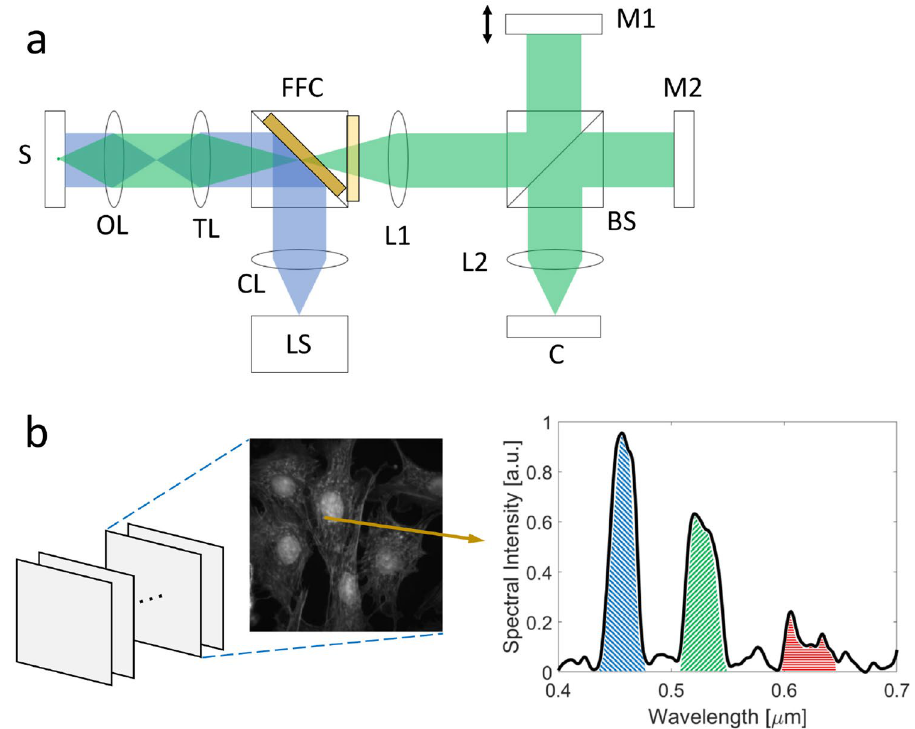
Figure 1. ( a ) Schematic diagram of the optical system showing the excitation beam path (blue) and emission beam path (green). LS: Light Source, CL: Collimating Lens, FFC: fluorescence filter cube, S: Sample, OL: Objective Lens, TL: Tube Lens, L1 and L2: Lenses, M1: Moving Mirror, M2: Stationary Mirror, BS: beam splitter, and C: Camera. ( b ) Interferogram image set and resulting spectral intensity. ( a ) and ( b ) created with Microsoft PowerPoint ver. 2111 Build 14701.20262 (https:// produ cts. office. com/ en- us/ power point), graph in ( b ) exported from MATLAB ver. 9.10.0.1602886 (R2021a) (https:// www. mathw orks. com/ produ cts/ matlab.